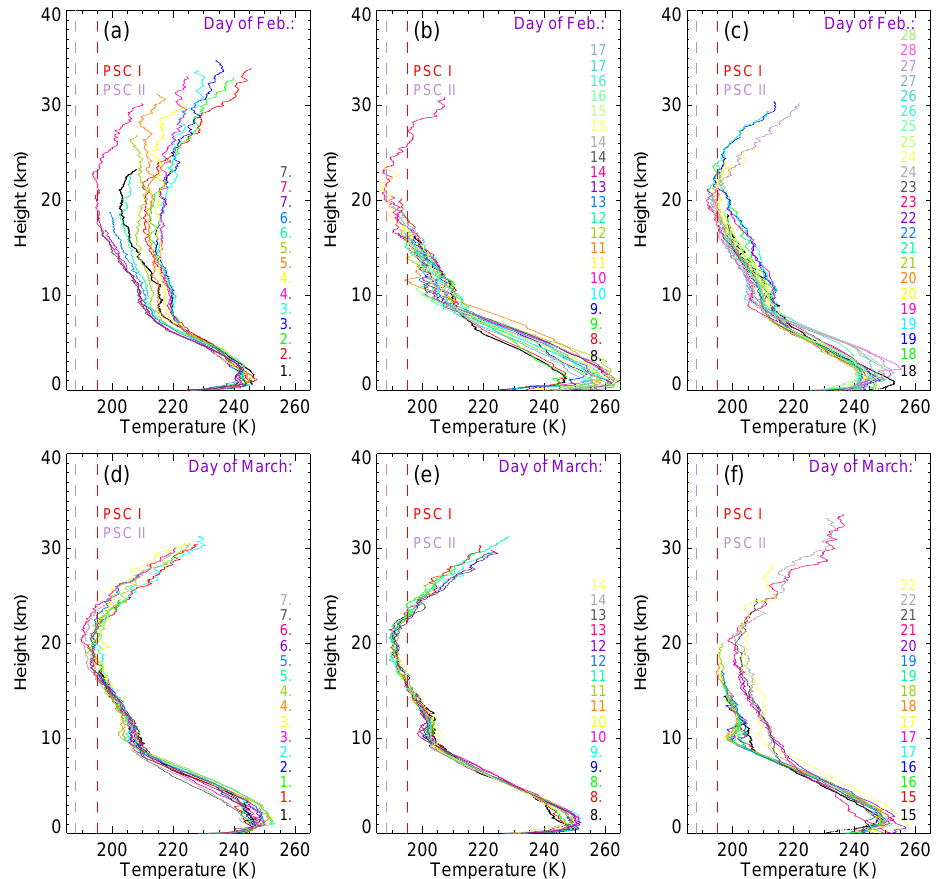
Fig. 3. Radiosonde temperature profiles for 1 to 28 February (panels a–c ) and 1 to 22 March (panels d–f ). The day is shown on the right side of each panel, color coded. The two dashed vertical lines correspond to the threshold temperature values for the formation of PSC type I (red) and PSC type II (purple). The division of days per plot was chosen to make the temperature drop below the PSC type I or PSC type II thresholds more visible.